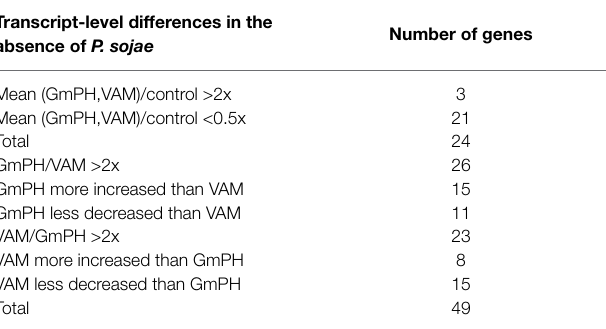
TABLE 1 | Transcript-level differences in the absence of Phytophthora sojae . Transcript-level differences in the absence of P. sojae